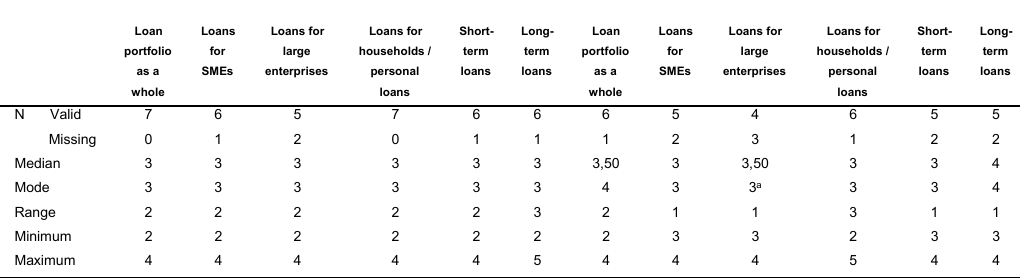
Table 5. The impact of renewed regulation on loan terms.